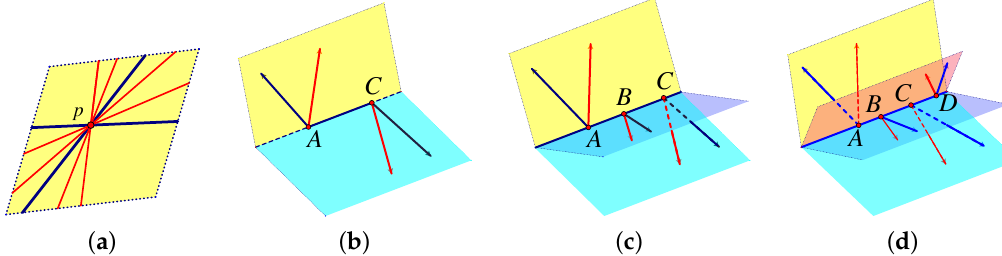
Figure 49. ( a ) two independent intersecting lines generate a plane pencil (red lines) which are linear combinations of the original lines. ( b ) shows three independent lines which generate two plane pencils. ( c ) shows four independent lines which generate three plane pencils that share a common line. ( d ) shows five independent lines which share a common line and generate four plane pencils sharing a common line which is the center of the singular line complex.